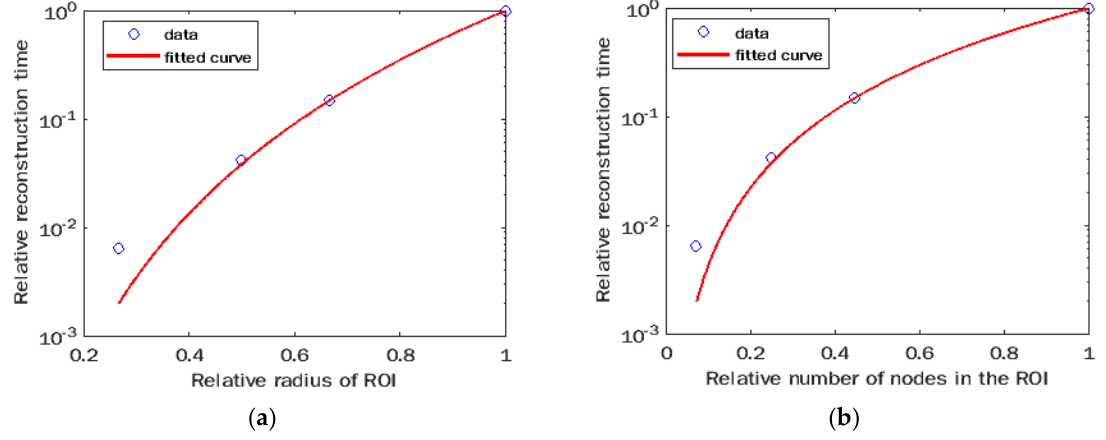
Figure 2. The comparison of reconstructed photoacoustic intensities (absorbed optical energies) across the center of the simulated target by using a full zone-based FE-PAT algorithm and localized FE-PAT algorithm in various ROI sizes (R = 10.0 mm, R = 7.5 mm and R = 4.0 mm).